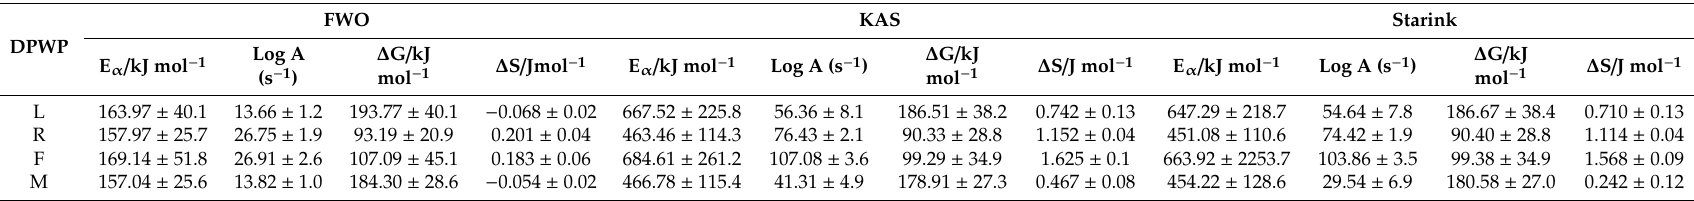
Table 4. The average activation energies and thermodynamic parameters of leaflet (L), rachis (R), fiber (F), and (d) composite (M) samples of DPWP determined by three model-free